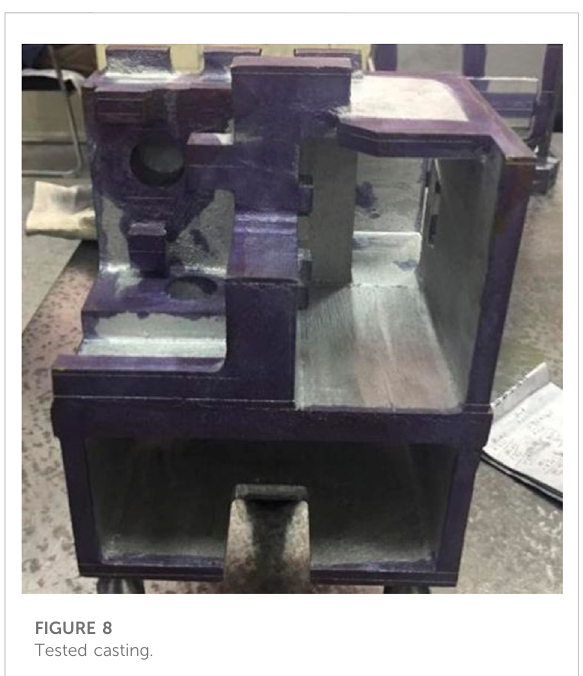
FIGURE 8 Tested